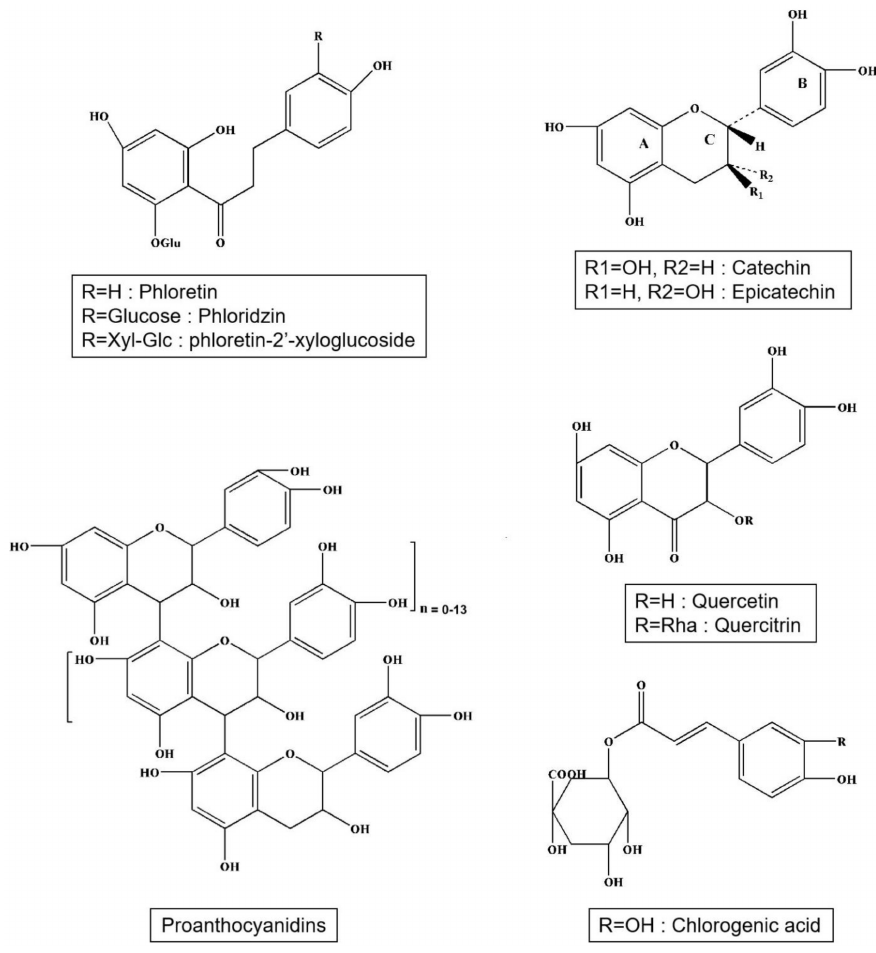
Figure 1. Structures of main phenolic acids, dihydrochalcones and flavonoids in apple. Table 2. The lists of phenolic acids isolated from